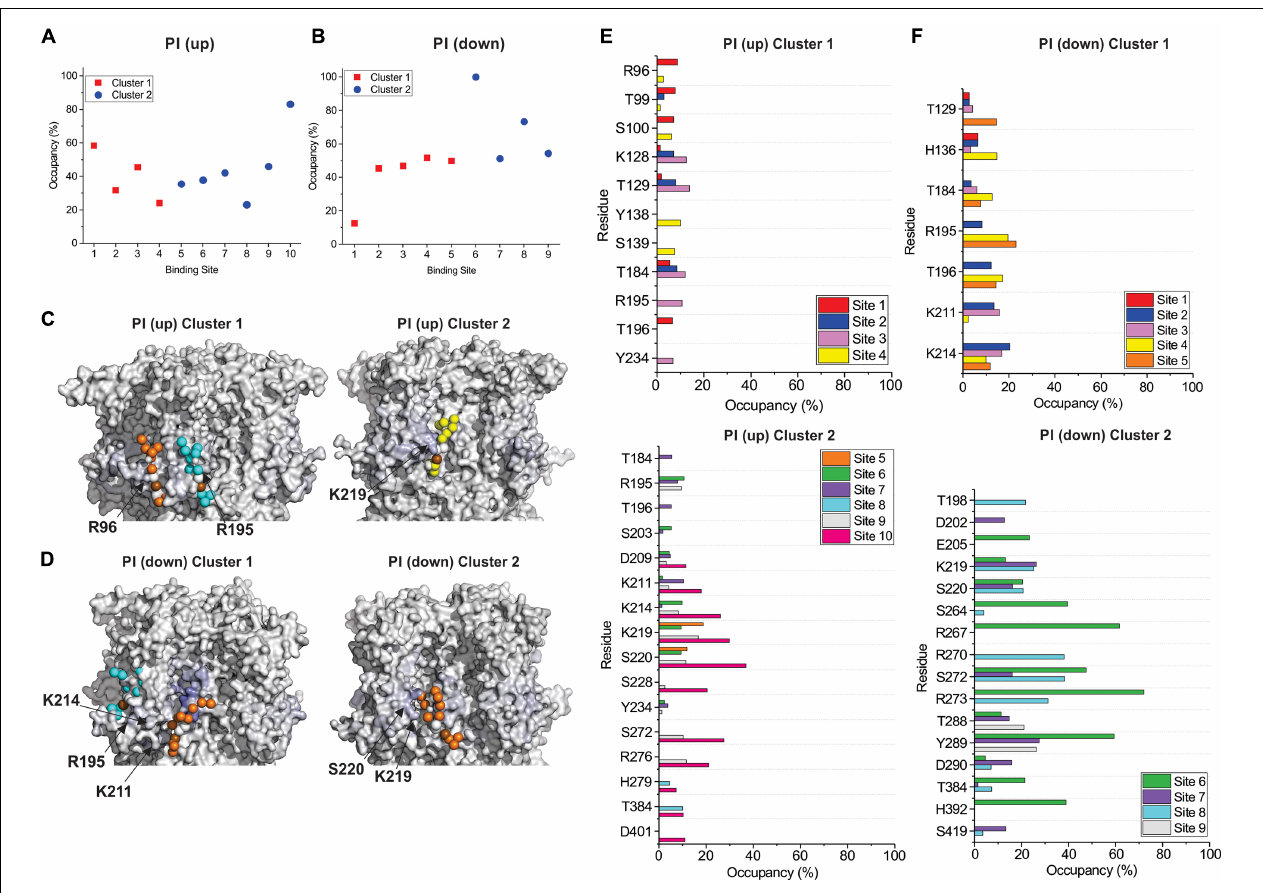
FIGURE 7 | Coarse-grained simulations identify weak binding of POPI to HCN1 with up (closed) and down (activated) VSDs. Occupancy (percentage of frames) of each lipid binding site in the HCN1 tetramer identified and quantified using PyLipid software for HCN1 up (A) and HCN1 down (B) . Binding sites were clustered according to the commonality of residues involved in binding with 2 low occupancy POPI binding sites identified. (C) Snapshots of POPI lipids (colored balls) bound to HCN1 up (C) and HCN1 down (D) (surface representation). Residues are colored according to occupancy throughout the trajectory from white (0%) to deep blue (100%) as in Figures 5 , 6 . Notably, the occupancy of lipid binding is not confined to a few residues, but smeared over a relatively large surface involving numerous residues. (E,F) Occupancy of PI-HCN1 interactions for each polar residue for HCN1 up (E) and HCN1 down (F) systems. In common with computational docking experiments, PI interactions occur over a larger number of residues than PIPs. With the VSD in the up state, PI interacts with the HCN domain (including R96, R126, K128) (up cluster 1) and in the S2 (R195) and S3 helices (K211, K214, and K219) (up cluster 2). However, with the VSD in the down state, binding occurs mostly at the S2 and S3 (down cluster 1), and somewhat deeper toward the pore (down cluster 2). And not near the HCN domain. The low occupancy of all POPI interactions indicates weaker binding of PI compared to